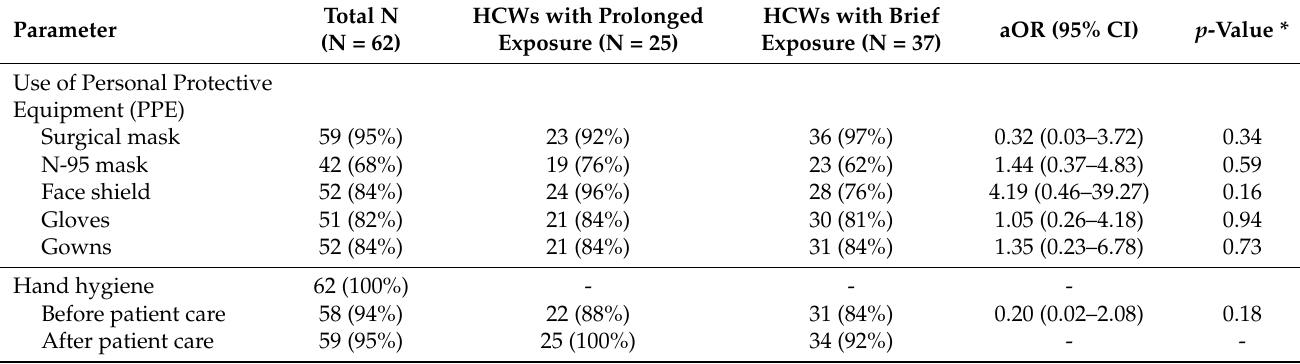
Table 2. Personal protection equipment and practices by healthcare workers and its association with time of